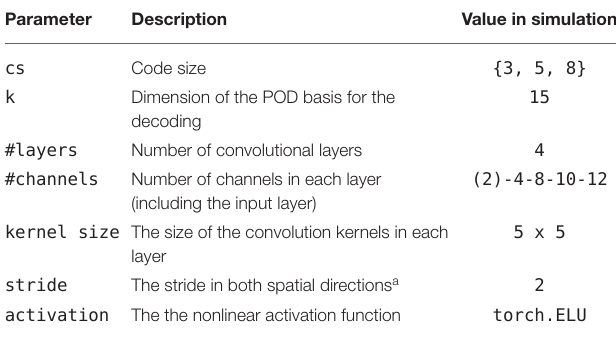
TABLE 1 | Table of parameters for the